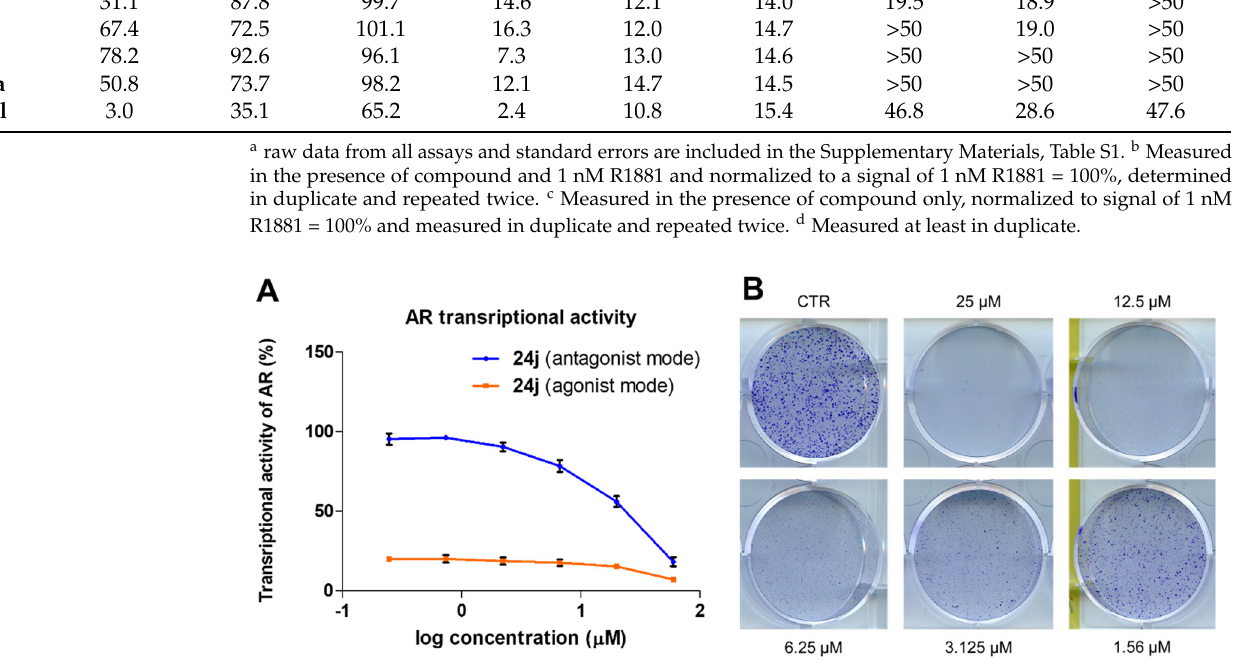
Figure 2. ( A ) Transcriptional activity of AR measured in reporter cell line in both antagonist (com- petition with 1 nM R1881) and agonist (presence of compound alone) mode upon treatment with different concentration of 24j . Mean and SD was plotted from n = 4. Raw data are available in the Supplementary Materials, Table S2. ( B ) Colony formation assay of PCa cells LAPC-4 after treatment with 24j for 10 days. The raw picture and comparison with the activity of standards abiraterone and galeterone is presented in Supplementary Materials, Figures S1 , S2 .